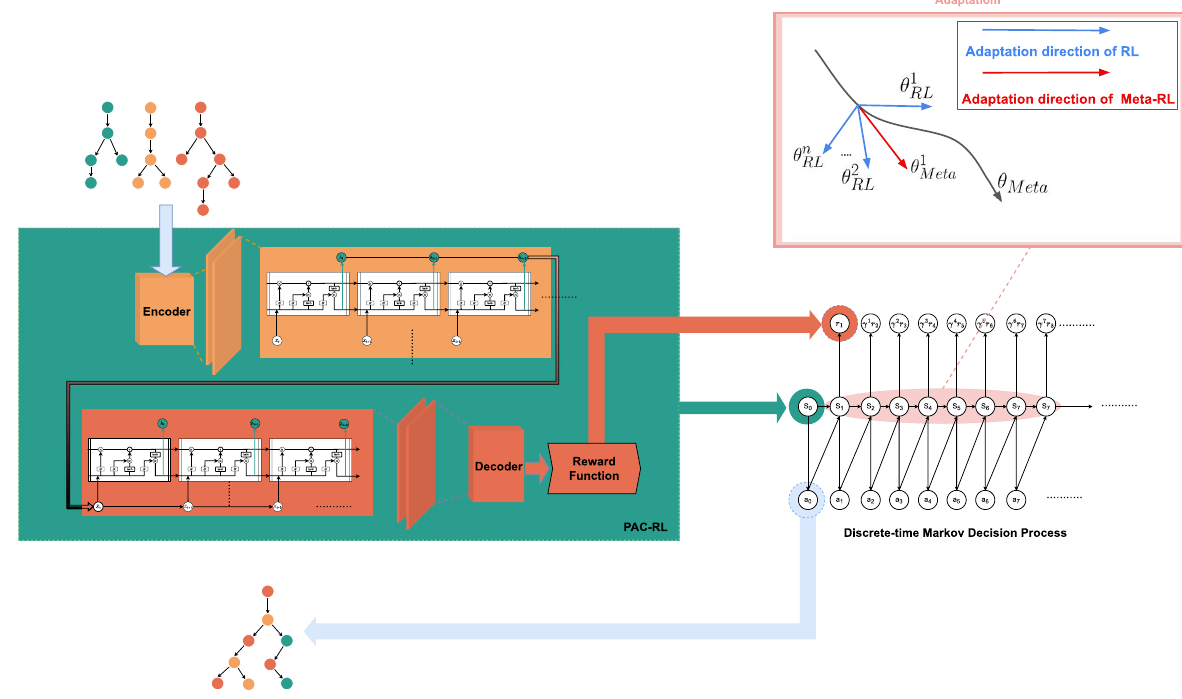
Fig. 4 Paradigm of